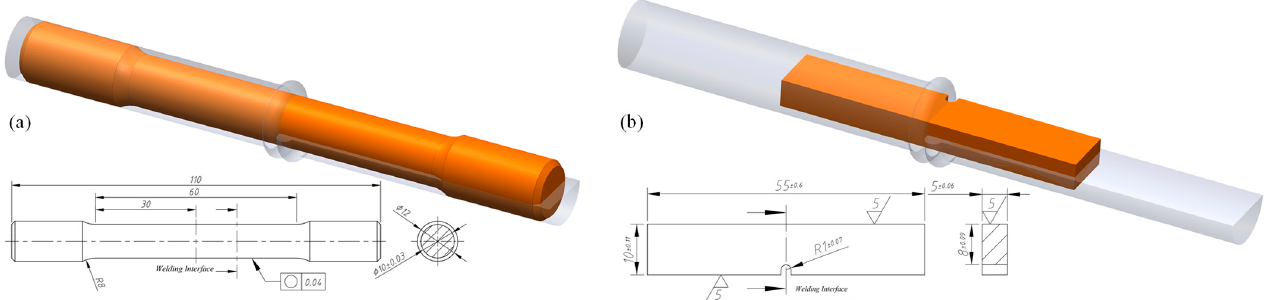
Figure 2. Tensile ( a ) and impact ( b ) test specimens.